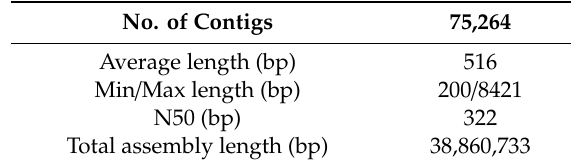
Table 1. Strong creeping red fescue transcriptome assembly.